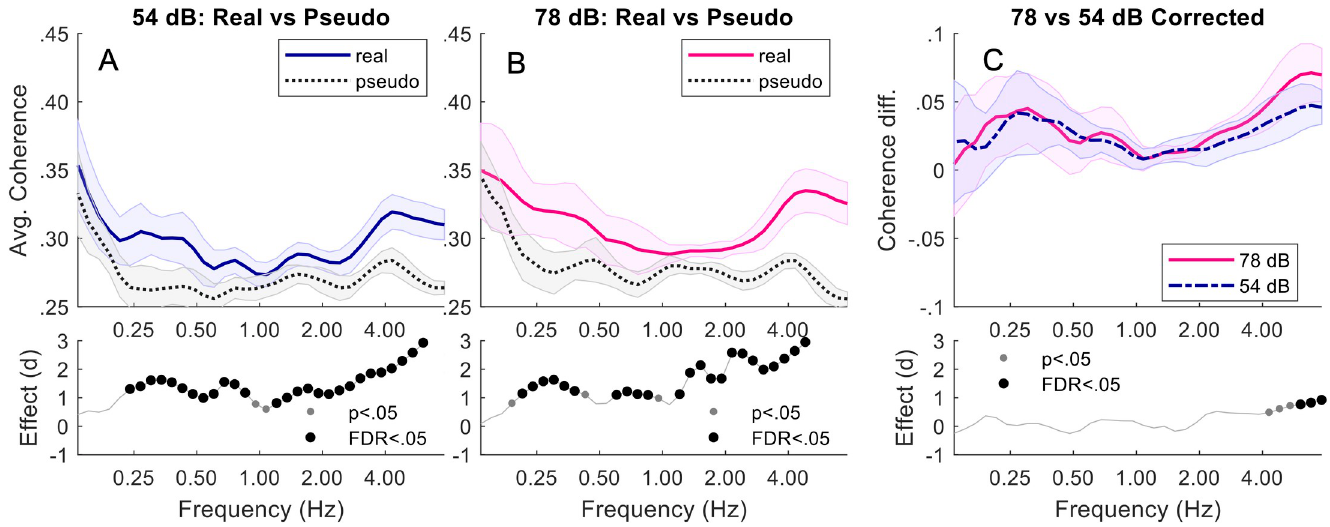
Fig 4. Triads in babble. Top plots of (A) and (B) show the average wavelet coherence responses for Real vs Pseudo during 54 dB and 78 dB respectively. The mean coherence over all triads (with standard error) is shown across a range of frequencies. The lower plots show the corresponding Pseudo-Real effect size (Cohen’s d), with both significance and FDR-adjusted significance. (C) shows the corrected (baseline removed) coherence difference between 78 and 54 dB.